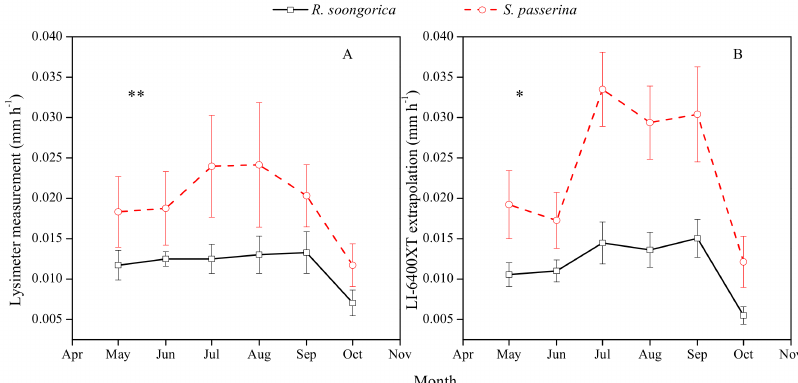
Figure 4. Seasonal changes of the hourly transpiration rate of R. soongorica and S. passerina by Lysimeter measurement ( A ) and LI-6400XT extrapolation ( B ) during the experimental period. Asterisks indicate significant differences between R. soongorica and S. passerina during the experimental period: * p < 0.05; ** p < 0.01; and *** p < 0.001.